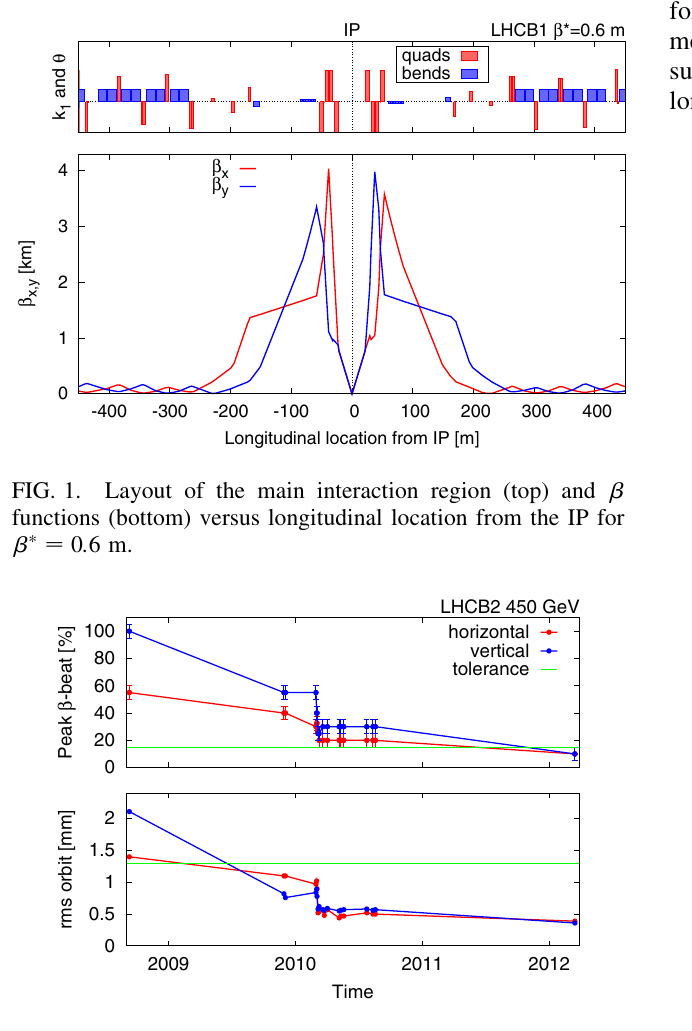
FIG. 2. Measured peak (cid:1) beating (top) and rms orbit (bottom) at injection for beam 2 versus time.